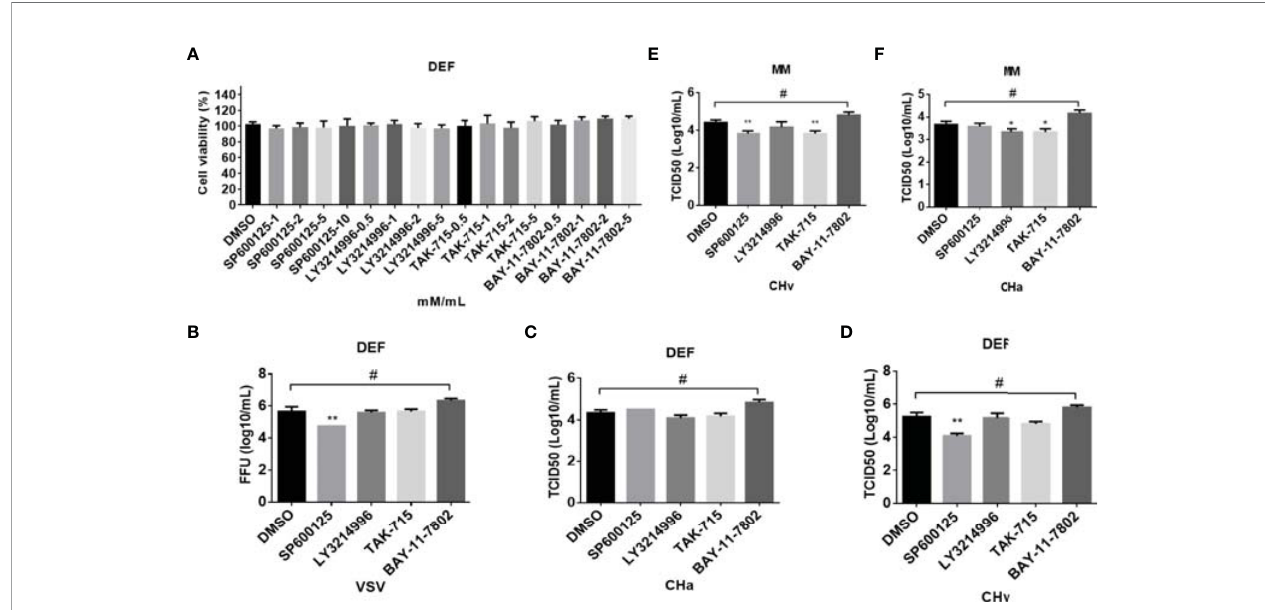
FIGURE 7 | The in fl ammatory signaling affects virus replication in DEF and MM cells. (A) The cell toxicity of the JNK, ERK, p38, and NF-kB inhibitor was determined through MTT. (B – F) The viral titer was detected. DEF cells were pretreated with SP600125 (JNK inhibitor), LY3214996 (ERK inhibitor), TAK-715 (p38 inhibitor) and BAY-117082 (NF-kBinhibitor) for 1 h at 10, 5, 5, and 5 M respectively,DMSO as control, then the cells were infected with VSV (B) , CHv (C,E) andCHa strain (D, F) at 1 MOI for 1 h,then the same concentration of inhibitor was added.At24 hpi,the cell culture supernatants were collectedand the FFU ofVSV-GFP and theTCID50 of CHa or CHv were determined on BHK21 or DEFcells. “ * ” was considered signi fi cant difference ( p < 0.05); “ ** ” was considered highly signi fi cant difference ( p < 0.01). "*"indicates signi fi cantly down-regulated group compared to DMSO group, "#" indicates up-regulated group compared to DMSO